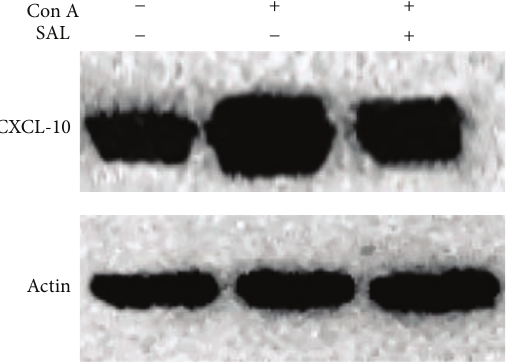
Figure 10: The effect of salidroside pretreatment on CXCL-10 protein expression. Salidroside pretreatment followed Con A administration attenuated CXCL-10 protein expression in the